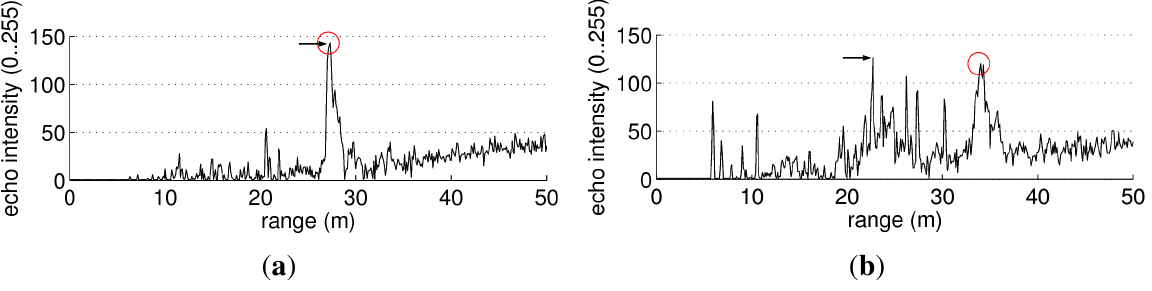
Figure 6. Two different beams. The circle marks the bin where the largest obstacle is located. The arrow points to the largest echo intensity. ( a ) A simple situation; ( b ) A more complex